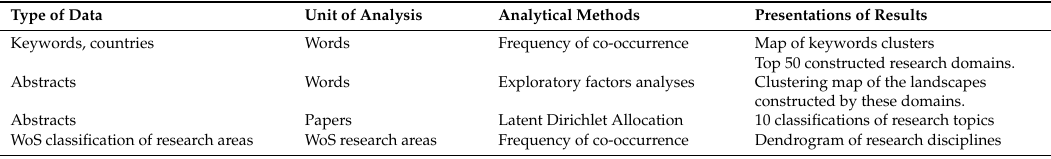
Table 1. Analytical techniques and presentations of results of each data